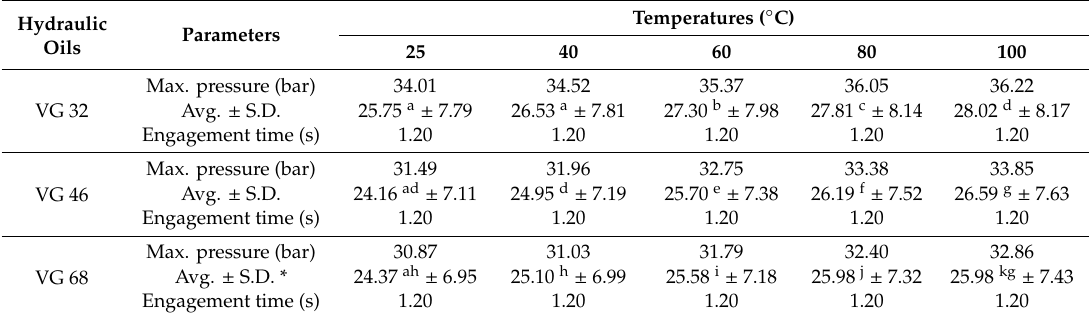
Table 7. The engagement pressures at di ff erent temperatures levels of the hydraulic oils. Hydraulic